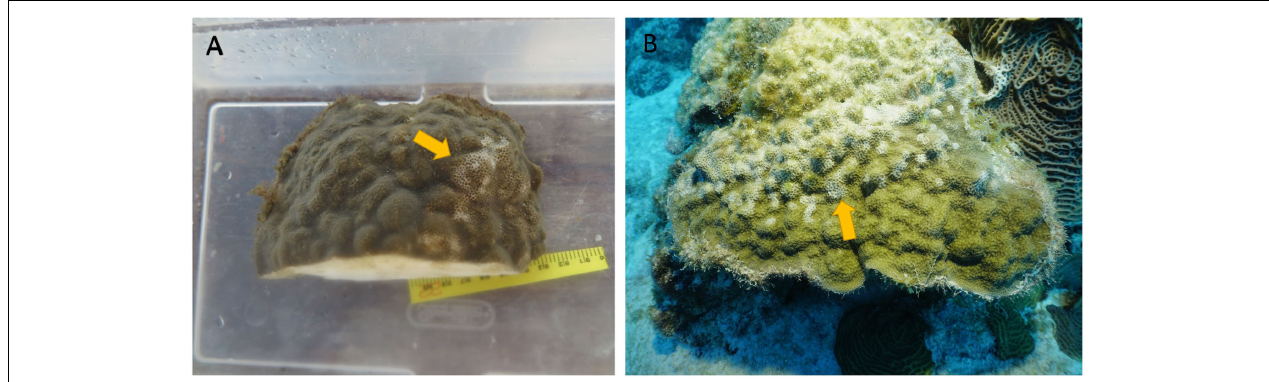
FIGURE 9 | (A) A Porites astreoides fragment exposed to a diseased colony of Diploria labyrinthiformis exhibiting lesions (yellow arrow) potentially indicative of early stony coral tissue loss disease (SCTLD) infection. (B) A Porites astreoides colony with severe damselfish predation (yellow arrow).